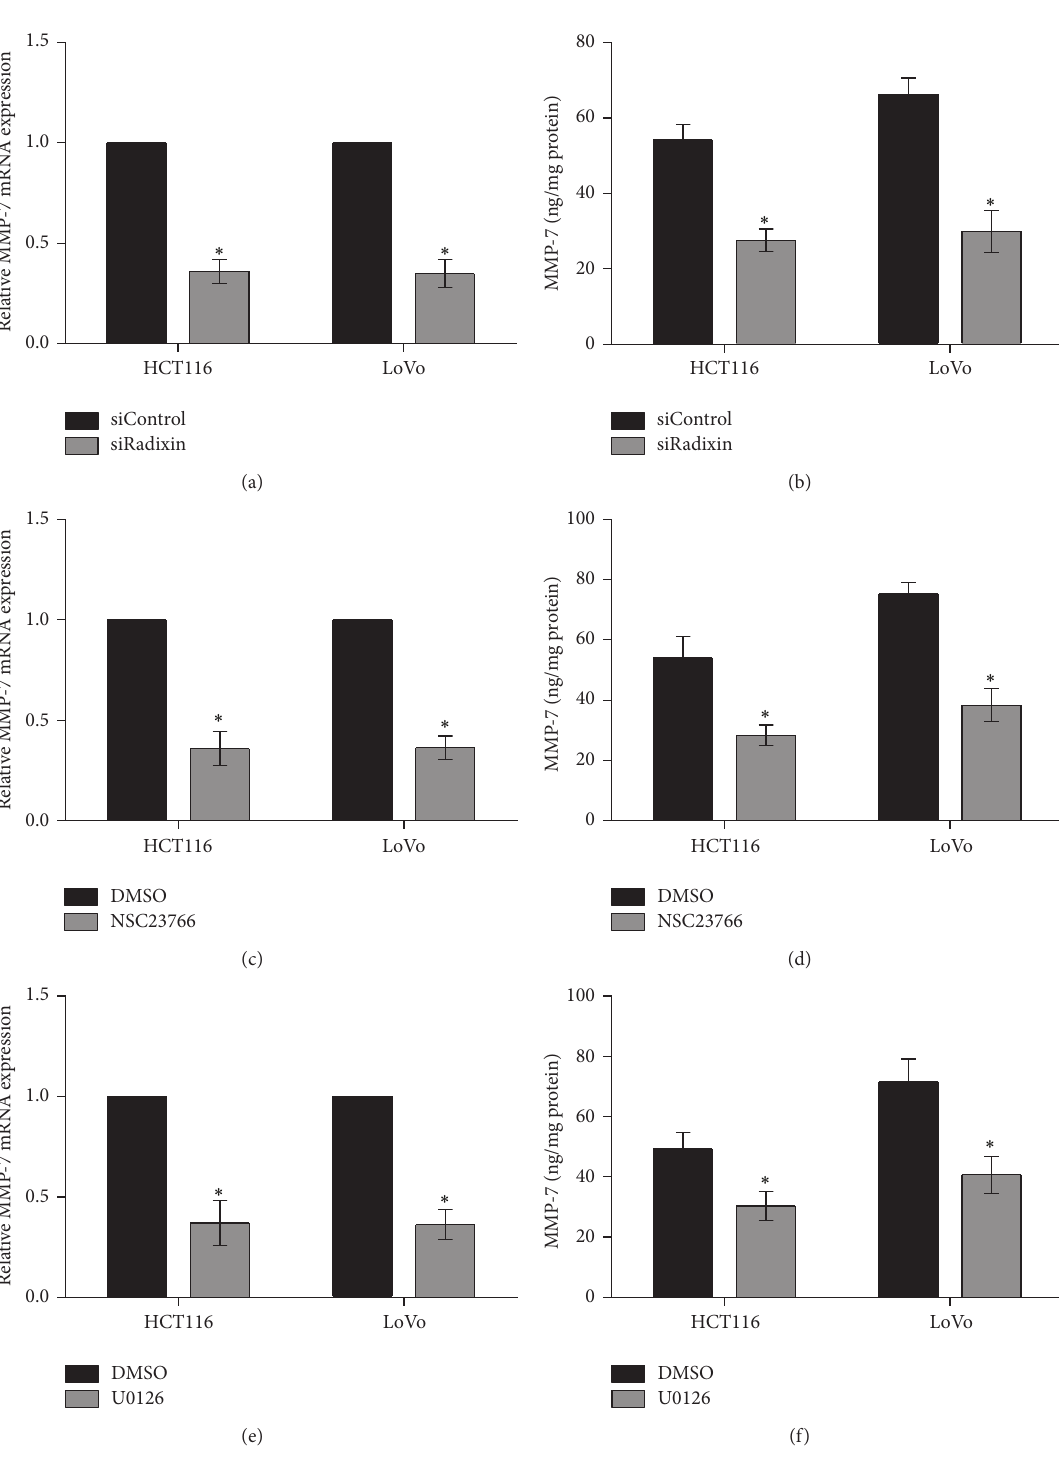
Figure 6: Rac1-ERK pathway was required for the radixin-mediated MMP-7 production. (a) and (b) After knockdown of radixin by siRNA, the production of MMP-7 was observed by real-time PCR and ELISA assay. (c) and (d) After incubation with NSC23766 or DMSO for 12h, MMP-7 production was determined by real-time PCR and ELISA assay. (e) and (f) After incubation with U0126 or DMSO for 12 h, MMP-7 production was detected by real-time PCR and ELISA assay. ∗ 𝑃 < 0.05